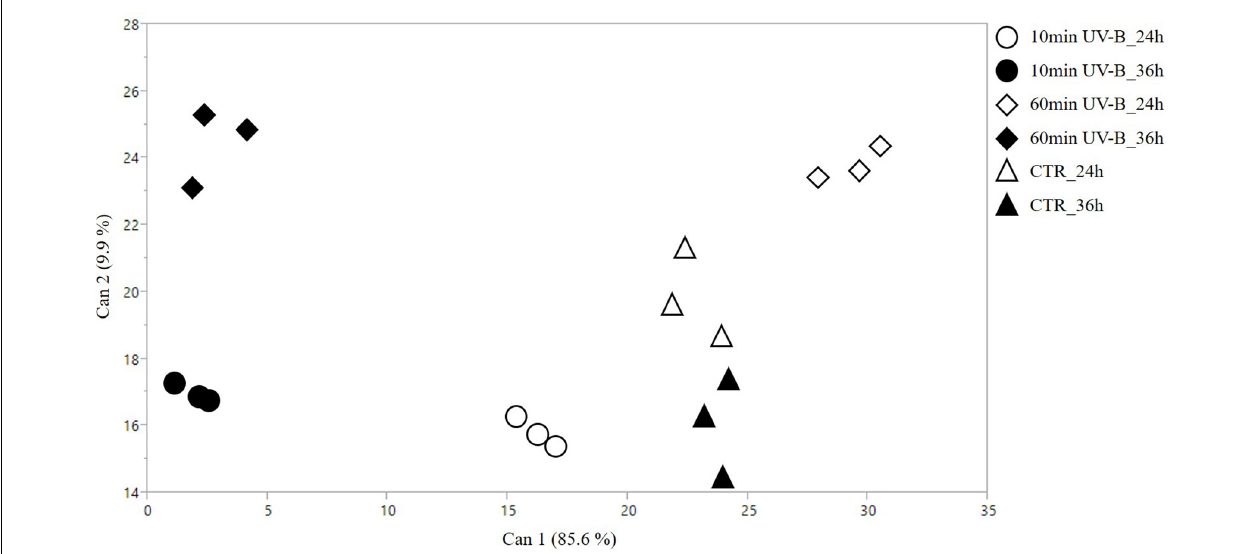
FIGURE 1 | 2D scatterplot of canonical discriminant analysis (CDA) considering the samples treated with 10 and 60 min of UV-B radiation after 24 and 36 h from the exposure, as well as the UV-B-untreated samples [controls (CTR)]. The whole phenolics dataset was used to perform this analysis. Can 1 and 2 refers to the canonical functions 1 and 2, which include all the variables to maximize the separation among the